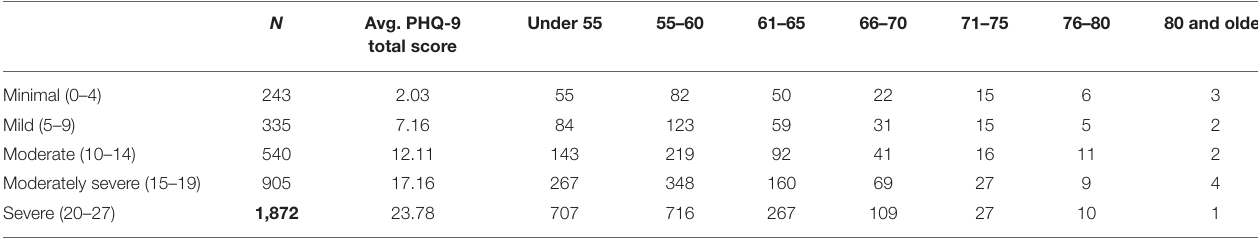
TABLE 4 | Prevalence of severity rates (total N =